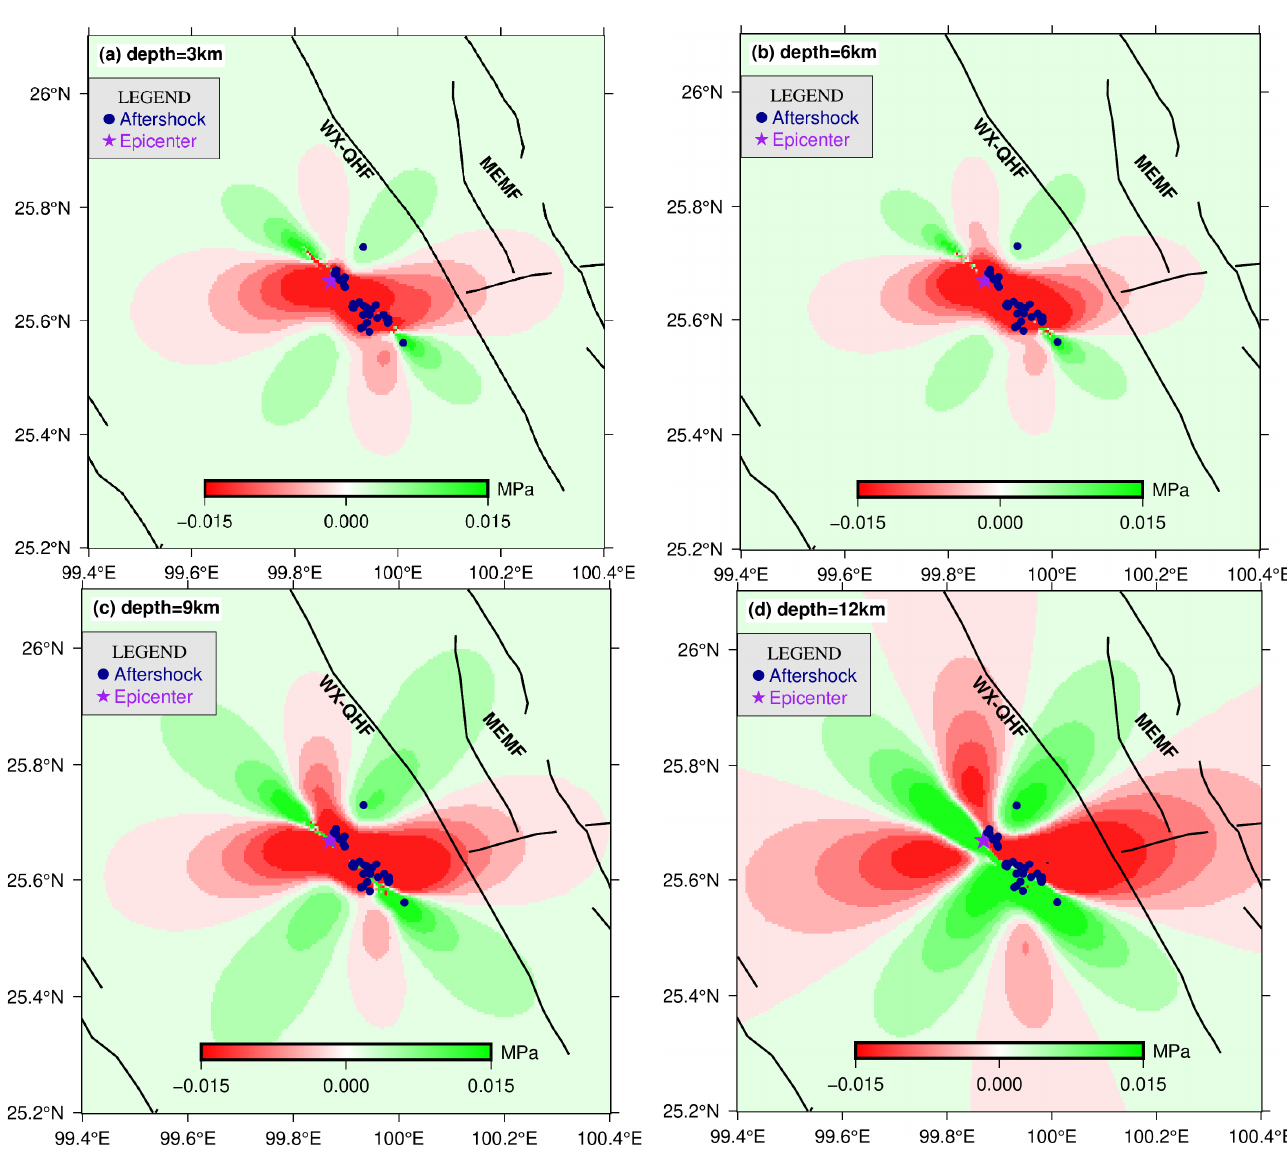
Figure 6. Coseismic Coulomb stress failure change caused by the Yangbi earthquake: ( a ) the depth of 3 km; ( b ) the depth of 6 km; ( c ) the depth of 9 km; ( d ) the depth of 12 km; the dark blue dots represent the distribution of aftershocks in a week after the earthquake. MEMF: the middle of the Eryuan-Midu Fault; WX-QHF; Weixi-Qiaohou Fault.